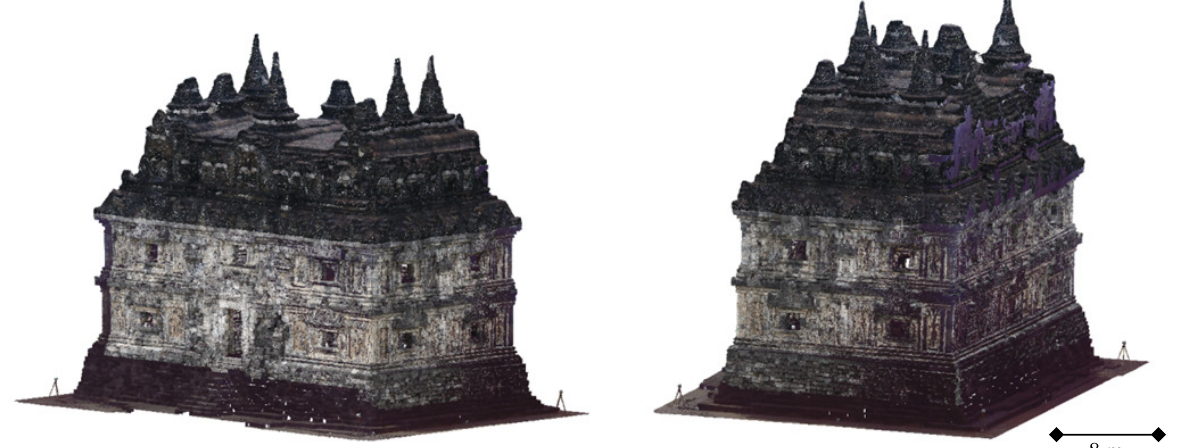
Figure 8. Illustration of the resulting fused point